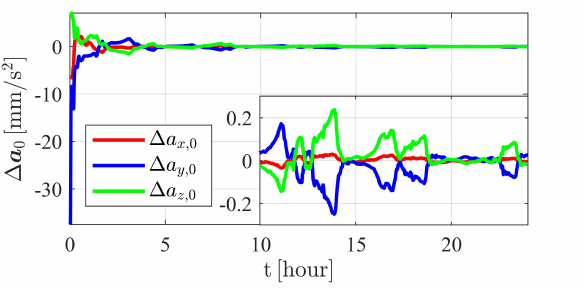
Figure 14. Maneuver estimated errors of the non-maneuvering case.